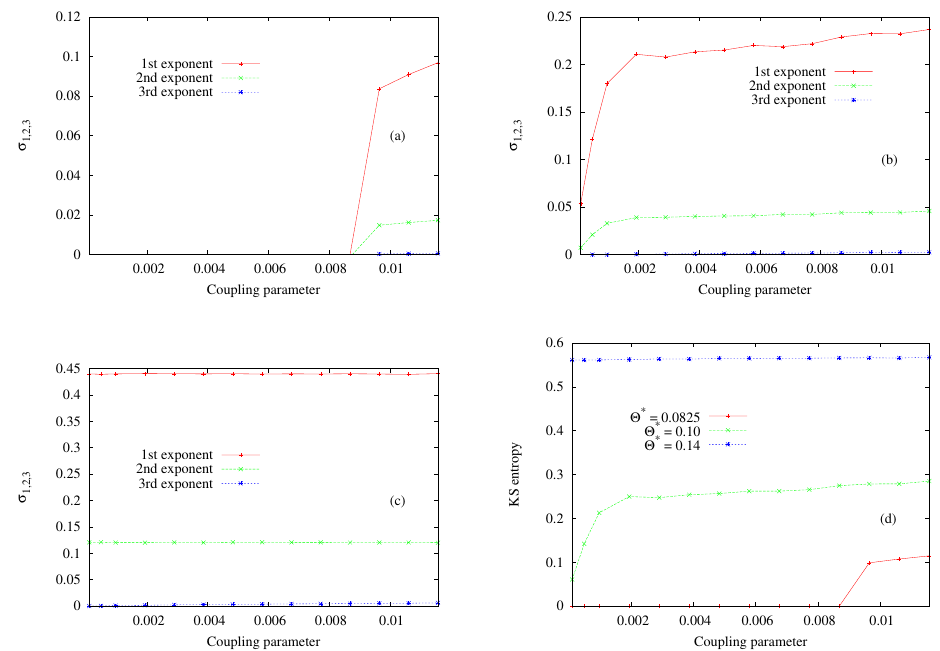
Fig. 6. Values of the first three Lyapunov exponents as a function of the coupling parameter δ for θ ∗ = 0 . 0825 (a) , 0 . 10 (b) , and 0 . 14 (c) . (d) Variation of the Kolmogorov–Sinai entropy as a function of δ for the same values of θ ∗ .